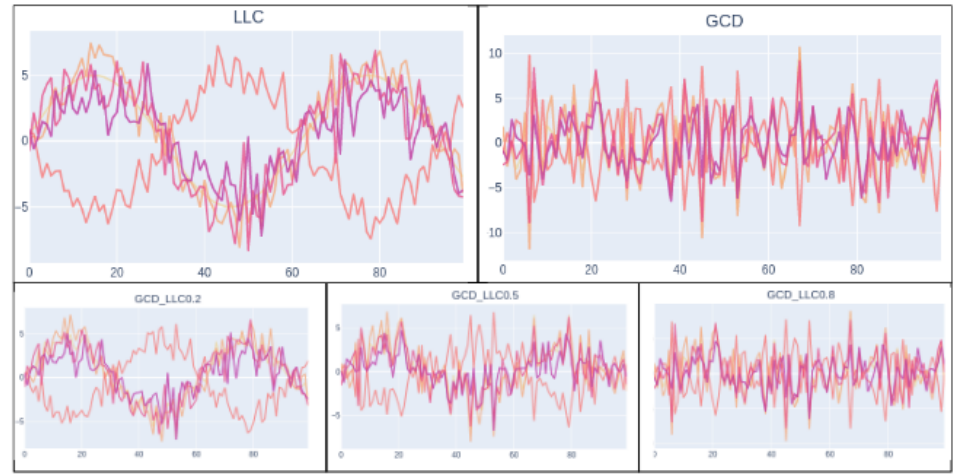
Figure 8. Illustrative multivariate time-series plot for each element of the synthetic data set collection. Lag linear combination (LLC) on the top left, Gaussian conditional distribution (GCD) on the top right, and hybrid (GCD_LLC_ α ) on the bottom for α values 0.2, 0.5, and 0.8 from left to right. We compared the Bayes network algorithms and Granger causality methods over this